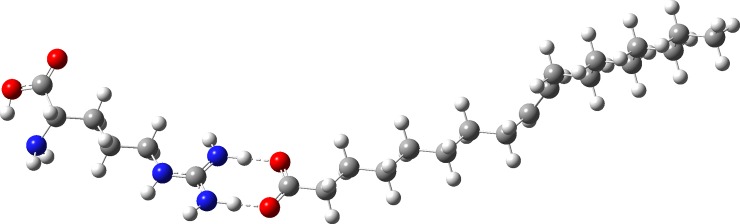
DFT optimized structure of H-bonded adduct between oleic acid (right) and L-ArgH+ (left) calculated in water.Oxygen atoms are depicted in red, nitrogen atoms in blue, carbon atoms in grey and hydrogen atoms in white.